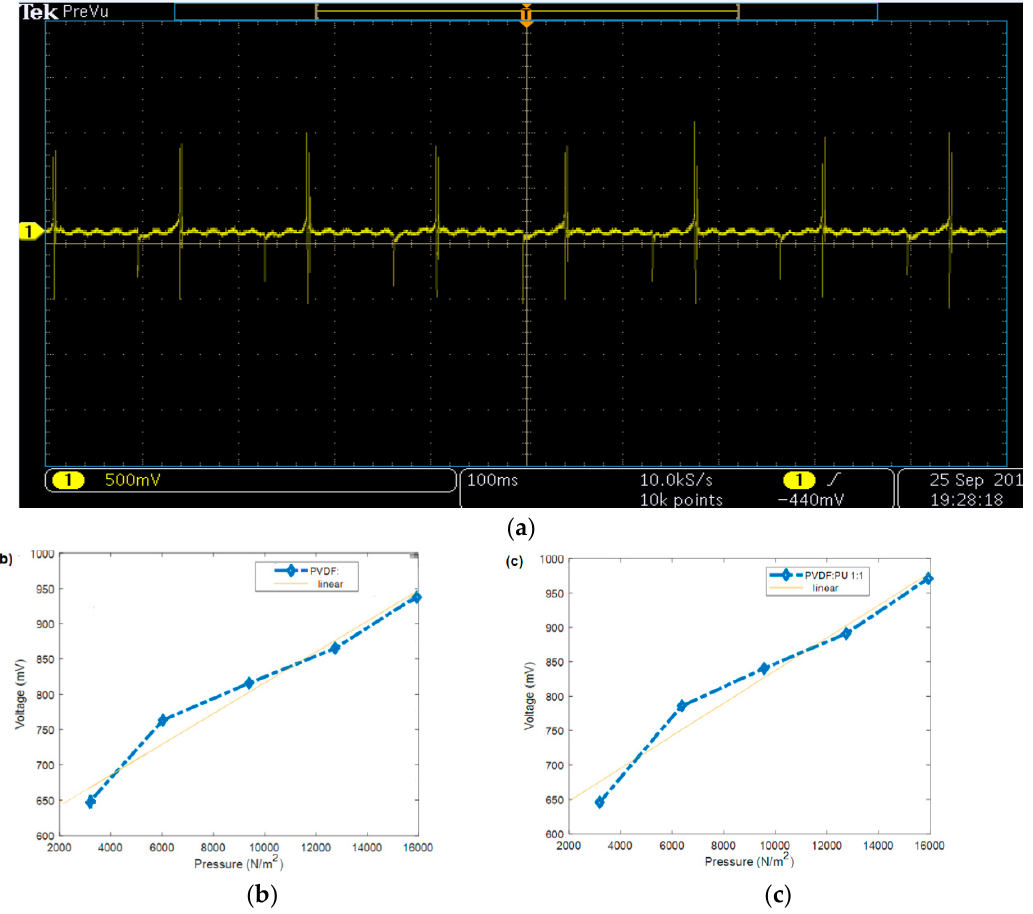
Figure 7. ( a ) Generated periodic voltage from one PVDF:TPU sample under periodic applied pressure, and examples of the relation between peak-to-peak output voltage and the applied pressure for ( b ) pure PVDF and ( c ) PVDF:TPU of 1:1.